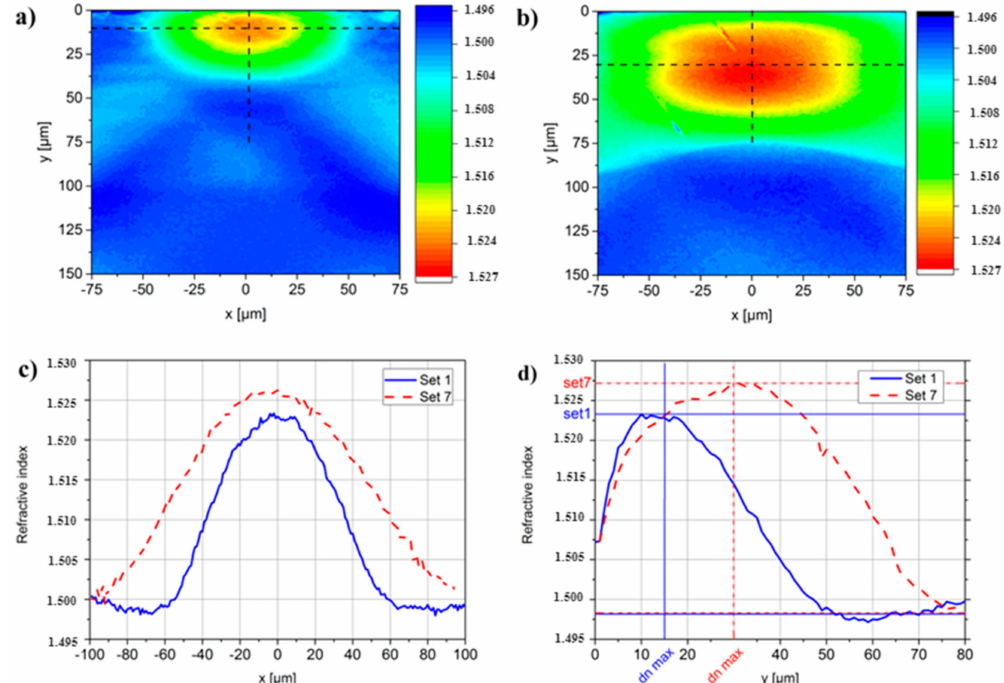
Figure 8. Refractive index profiles of selected glass waveguides with fabrication parameter sets 1 and 7: ( a ) Refractive index near field (RNF) scan of waveguide cross-section from parameter set 1, ( b ) RNF scan of waveguide from parameter set 7, ( c ) refractive index profiles along the horizontal axis of sets 1 and 7, ( d ) refractive index profiles along the vertical axis of sets 1 and